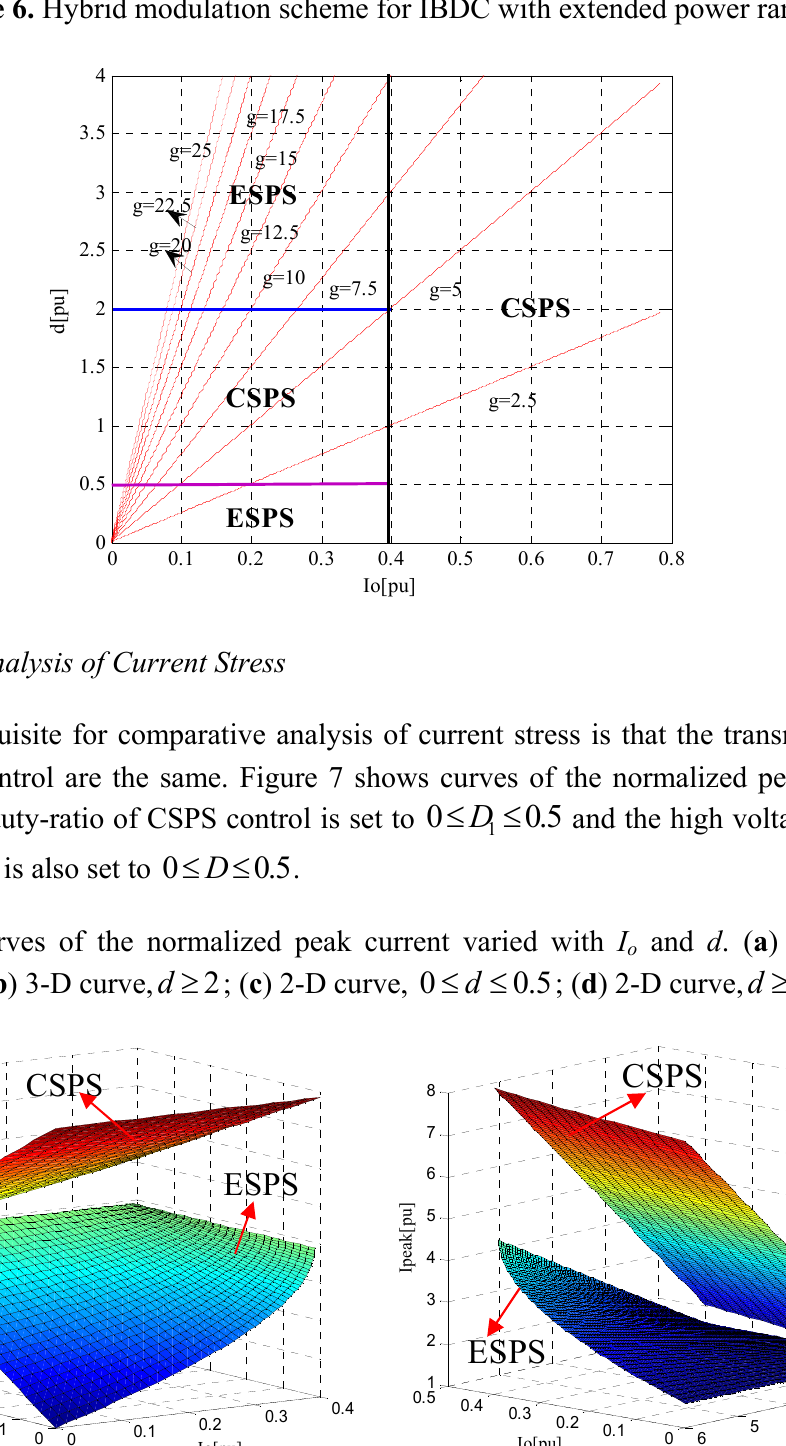
Figure 6. Hybrid modulation scheme for IBDC with extended power range.